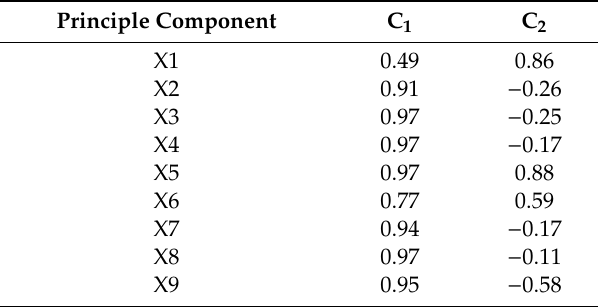
Table 8. Eigenvector of the two principle components.